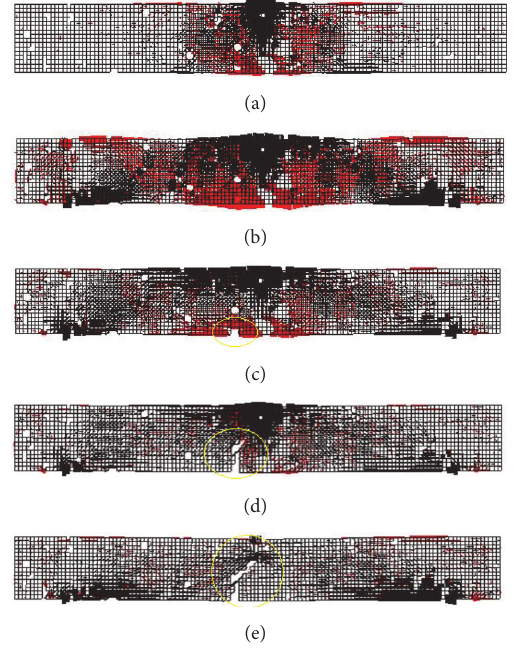
Figure 5: Illustration of different stages during virtual test: (a) initial loading; (b) maximum loading; (c) initiation of cracking; (d) extension of cracking; (e) penetration of cracking.